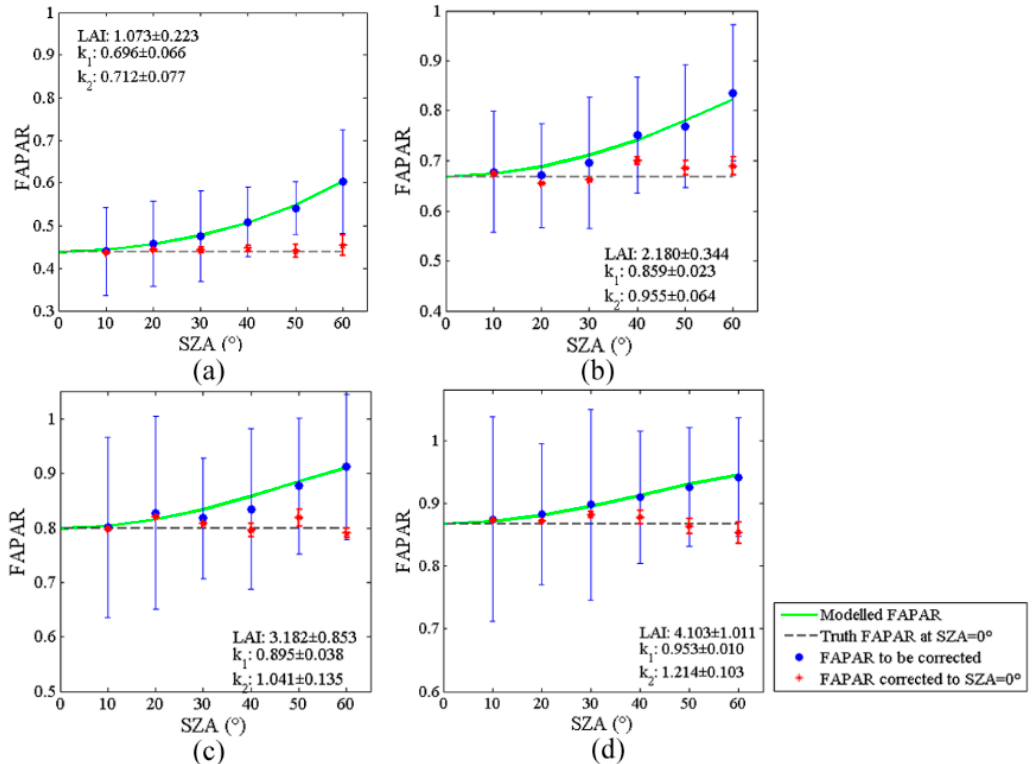
Figure 7. Sensitivity of FAPAR correction to random noises in input LAI and FAPAR measurement under VIS = 30 km given FAPAR = (1% ± 20%) of the truth FAPAR at different SZAs and: ( a ) LAI = 1.073 ˘ 0.223; ( b ) LAI = 2.180 ˘ 0.344; ( c ) LAI = 3.182 ˘ 0.853; and ( d ) LAI = 4.103 ˘